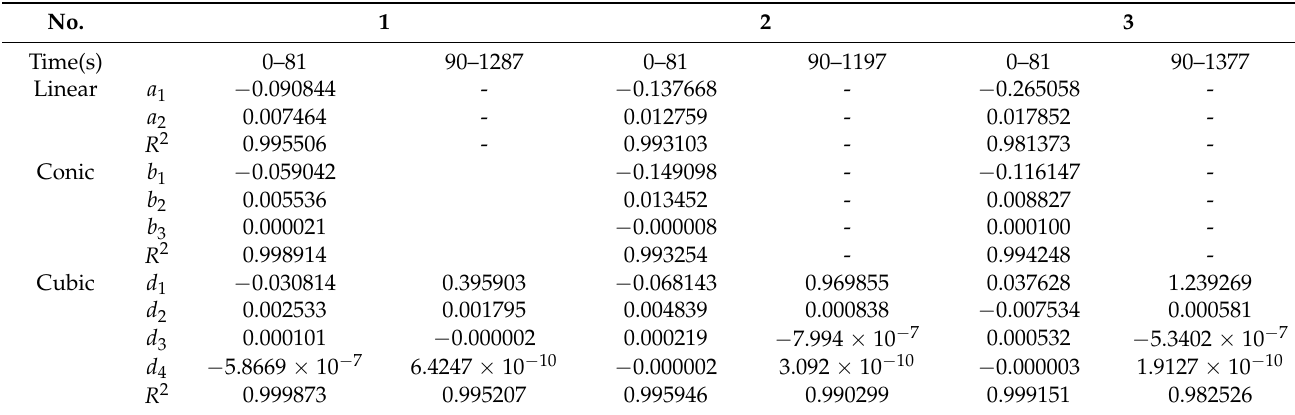
Table 3. The fitting parameters of the displacement of the three PGM